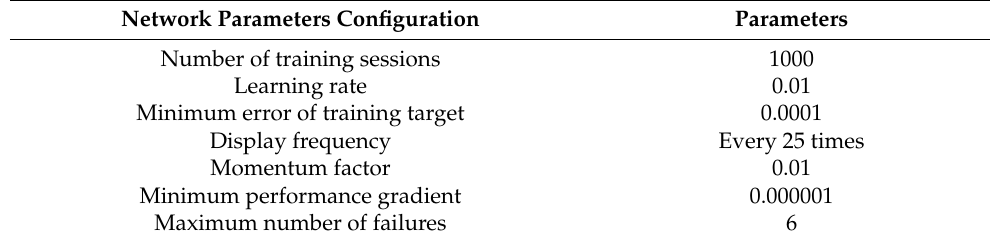
Figure 10. Neural network recognition flowchart. Table 1. BP network parameters.